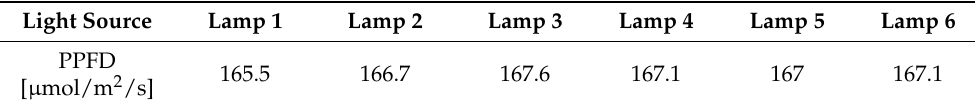
Table 1. The measured PPFD values for the applied lamps.